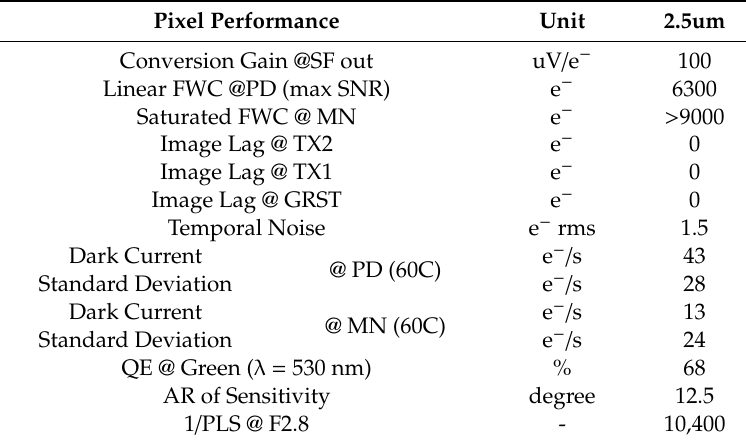
Table 2. Key pixel performances with